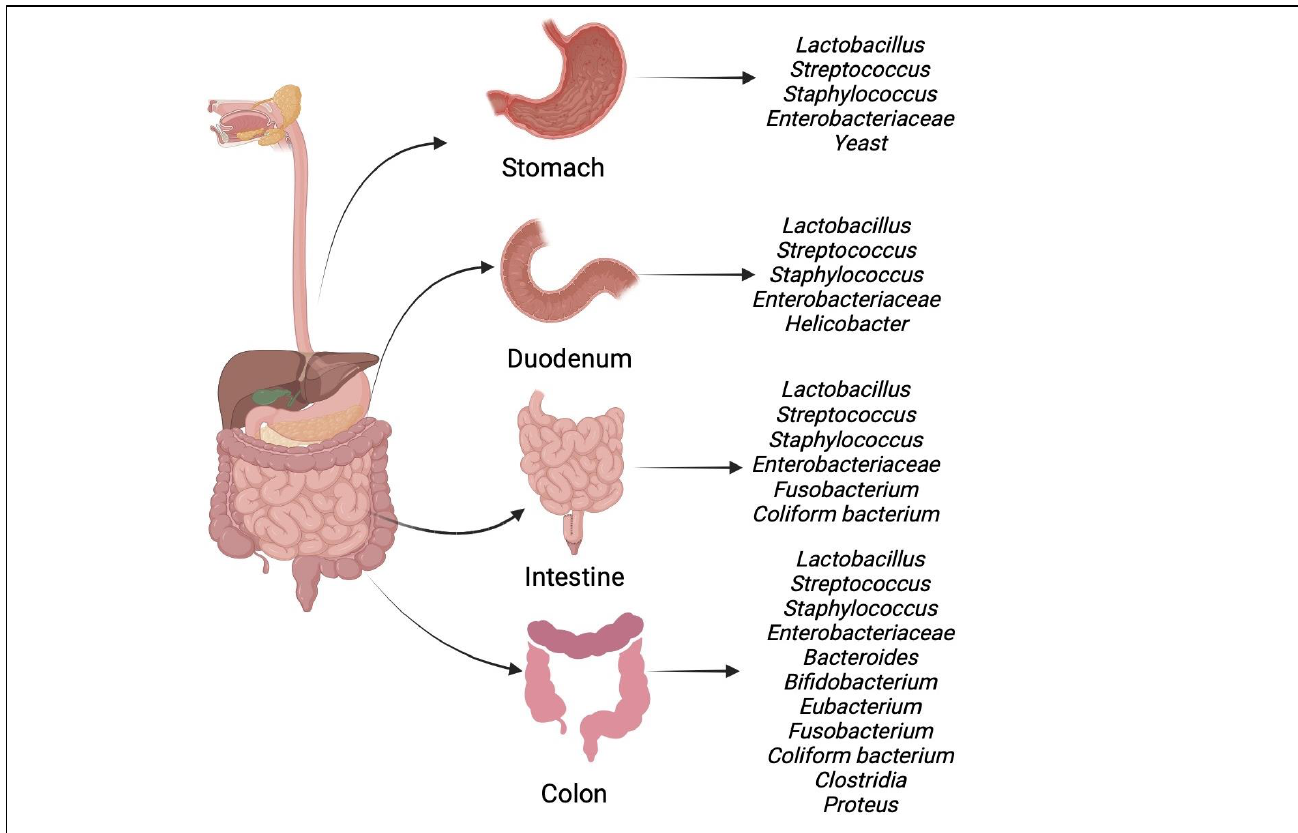
Figure 3. The composition of the microbiome varies with the position of the organ in the human body. This figure shows promising bacterial genera in the stomach, colon, and small intestine .